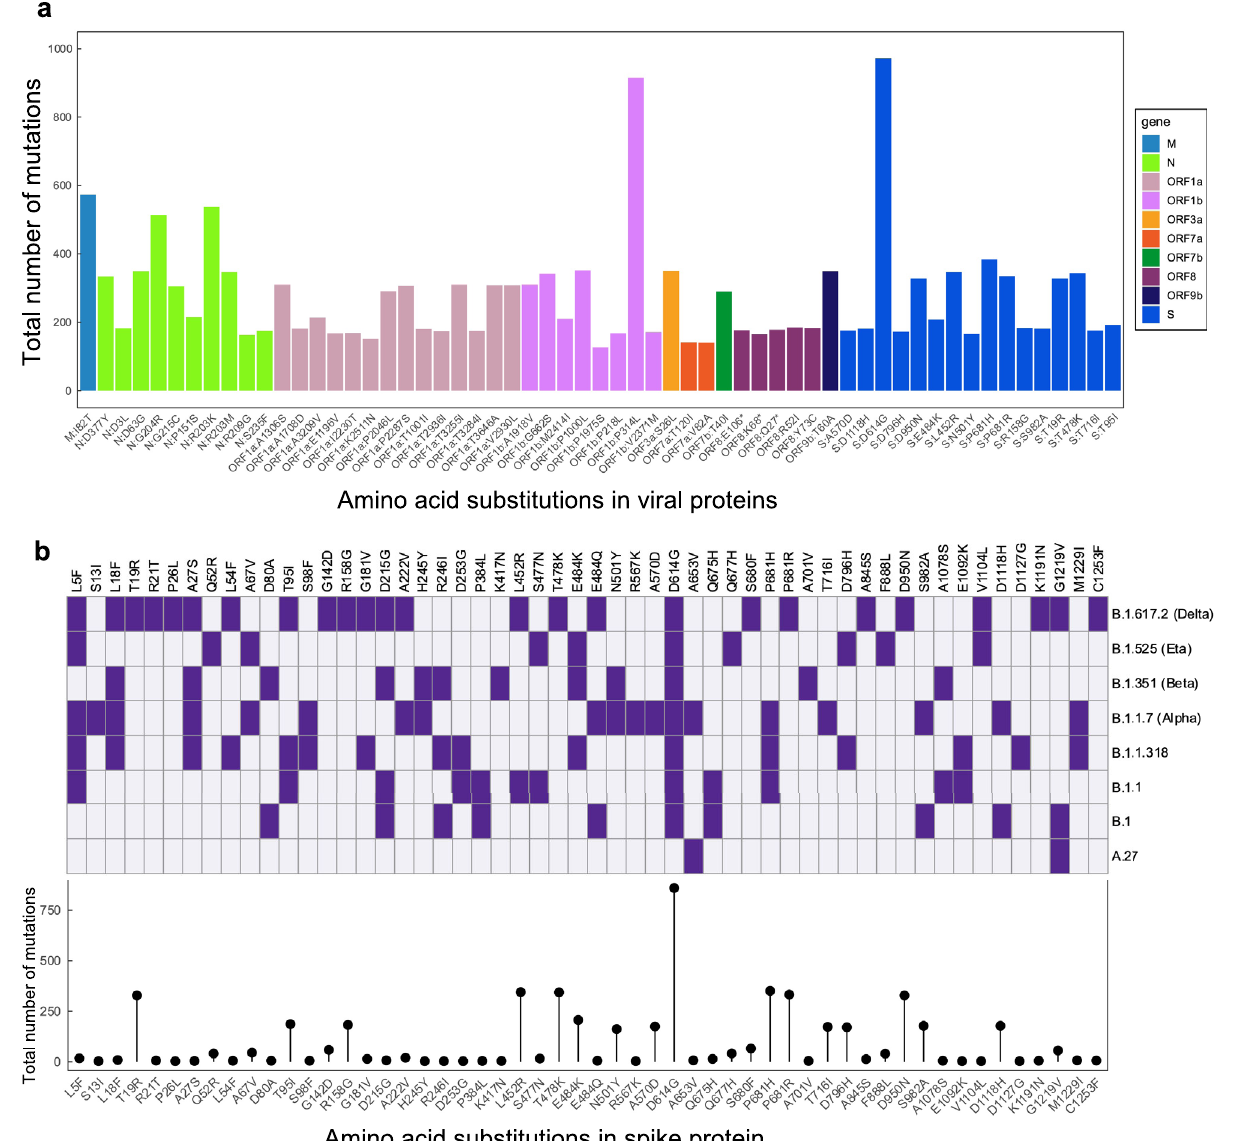
Fig. 4 Analysis of amino acid substitutions in variants circulating in Ghana. a Frequencies of amino acid substitutions across all the SARS-CoV-2 proteins in all genomes that were sequenced. The mutations are sorted and coloured per gene. b Spike glycoprotein amino acid substitutions present/absent in major SARS-CoV-2 variants circulating in Ghana. Purple shading indicates substitutions within the lineages, whereas white indicates the absence of the substitution in a particular variant in all the samples. The bottom panel plot shows the frequencies of individual substitutions across all the